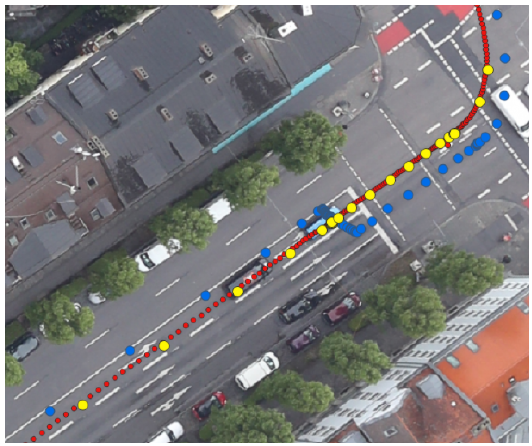
Figure 12. Map of reference and GNSS trajectories (yellow: reference, blue: mode D, and red: mode